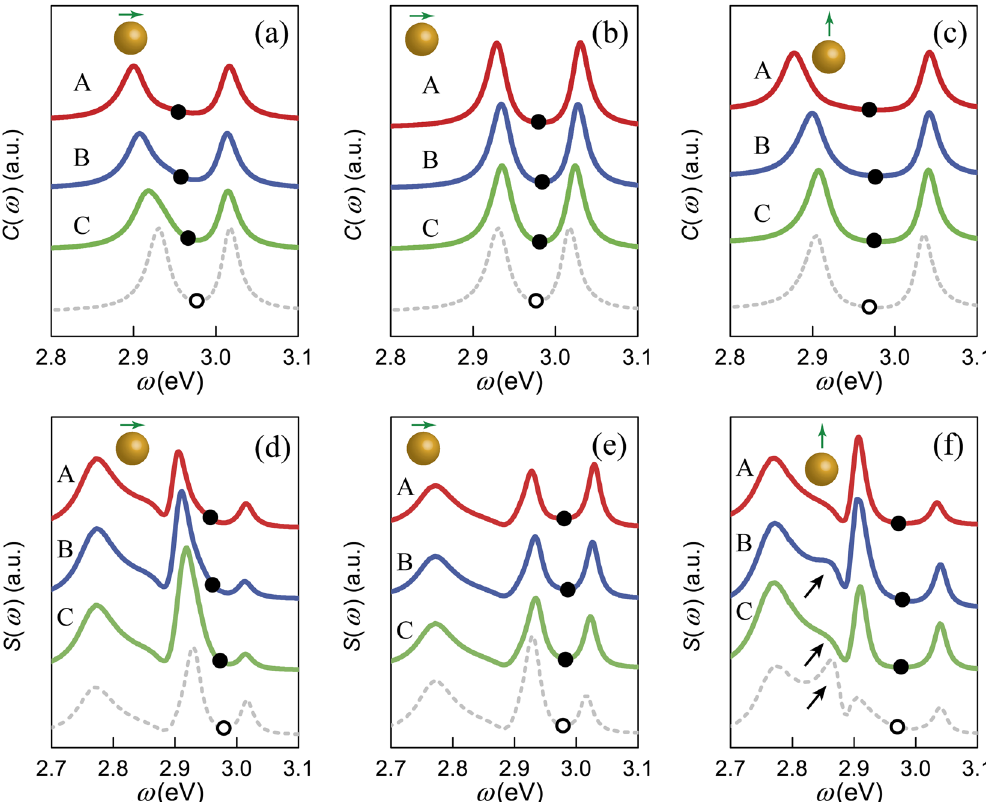
Figure 7. LSES of idealized MNP with a 0.5-nm-high bump located along the x-direction ( a ) and y-direction ( b ) for x-oriented dipole and along the y-direction for z-oriented dipole ( c ). Curves A, B, and C correspond to models A, B, and C in Fig. 3, respectively, whose θ values are 0.4 rad (red line), 0.55 rad (blue line), and 0.7 rad (green line). ( d – f ) are the corresponding FFDS for models ( a–c ). Transition frequencies are indicated by black dots and hollow dots on the curves for MNPs with a bump and idealized MNP,